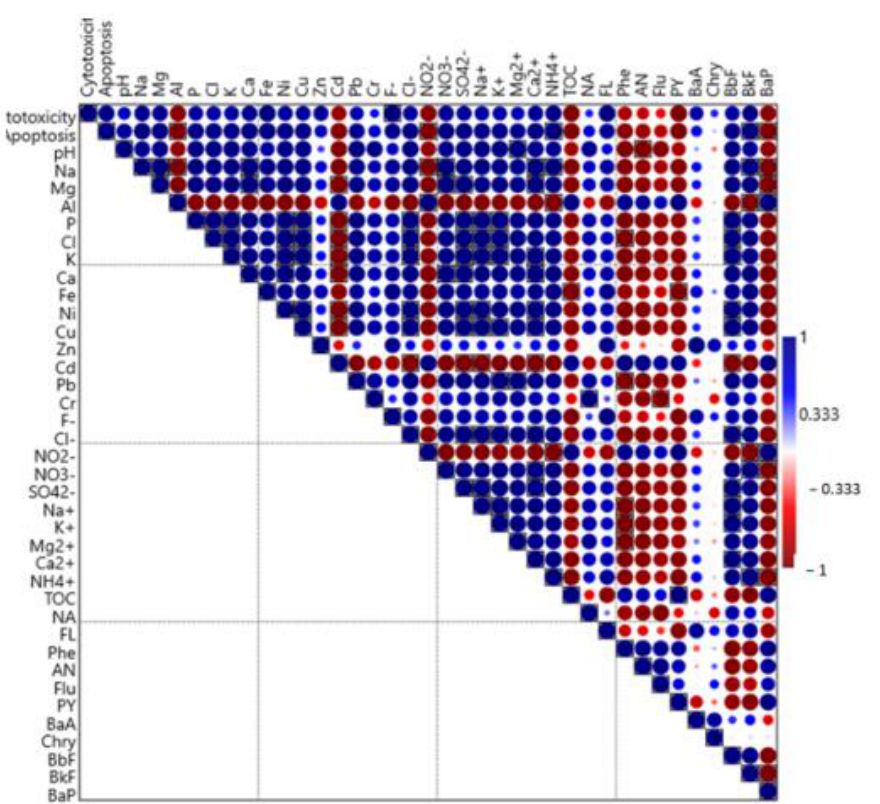
Figure 7. Pearson’s correlation analysis between the main properties of SF and cytotoxicity and apoptosis level. The boxed points correspond with significance correlation at p < 0.05.